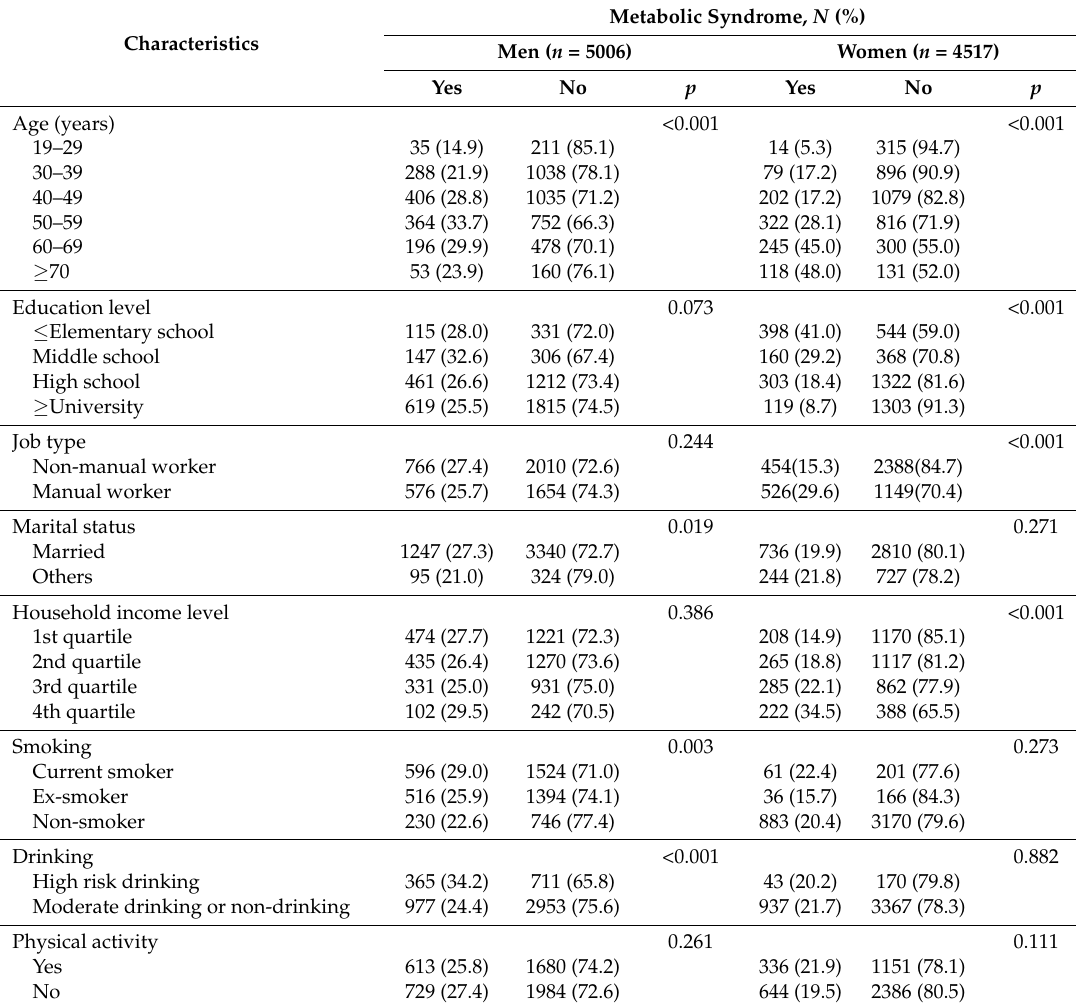
Table 1. General characteristics of subjects included in the study to determine metabolic syndrome prevalence ( N =